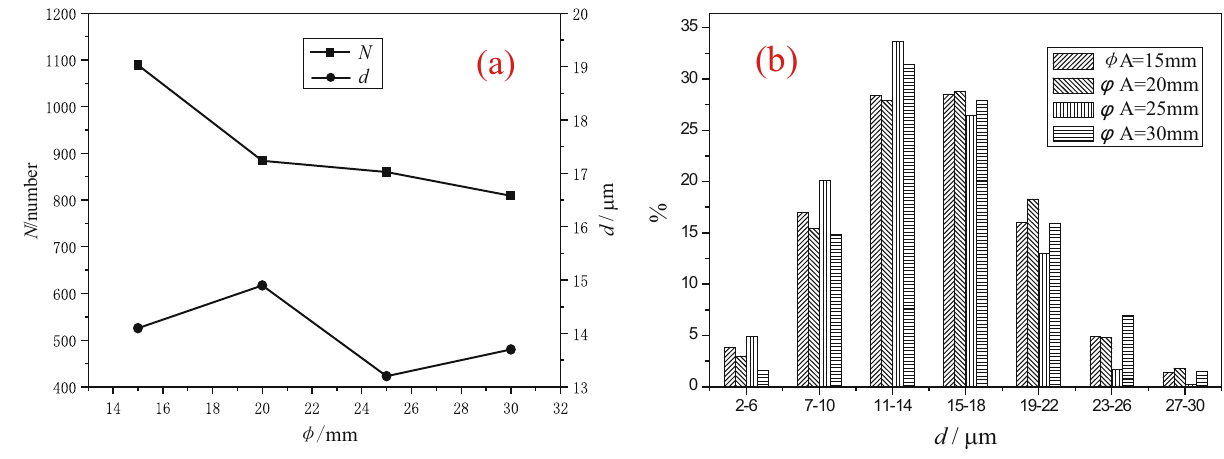
Figure 3: Graphite nodules: ( a ) number and diameter; ( b ) size